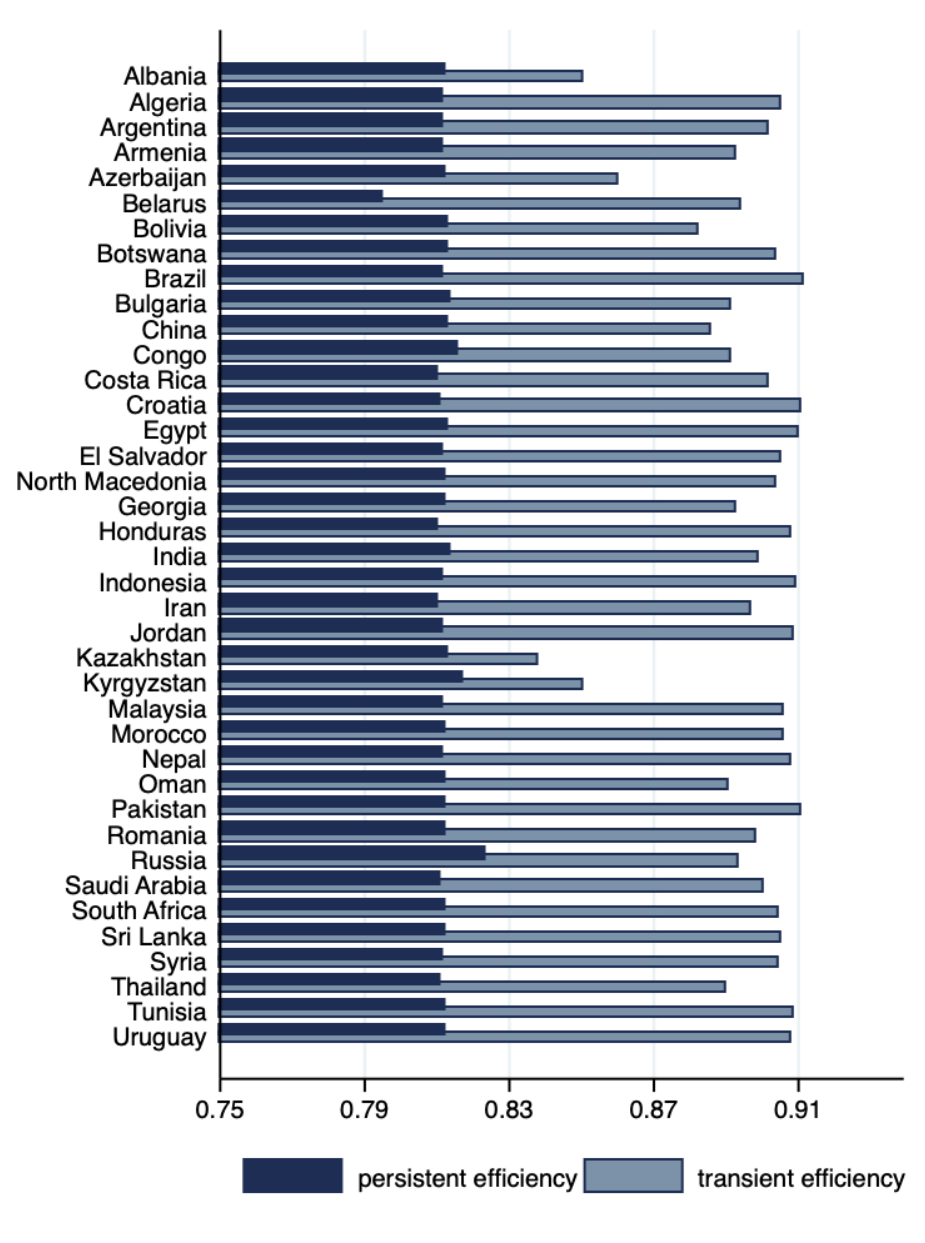
Figure 1. Estimated persistent and transient efficiency in developing